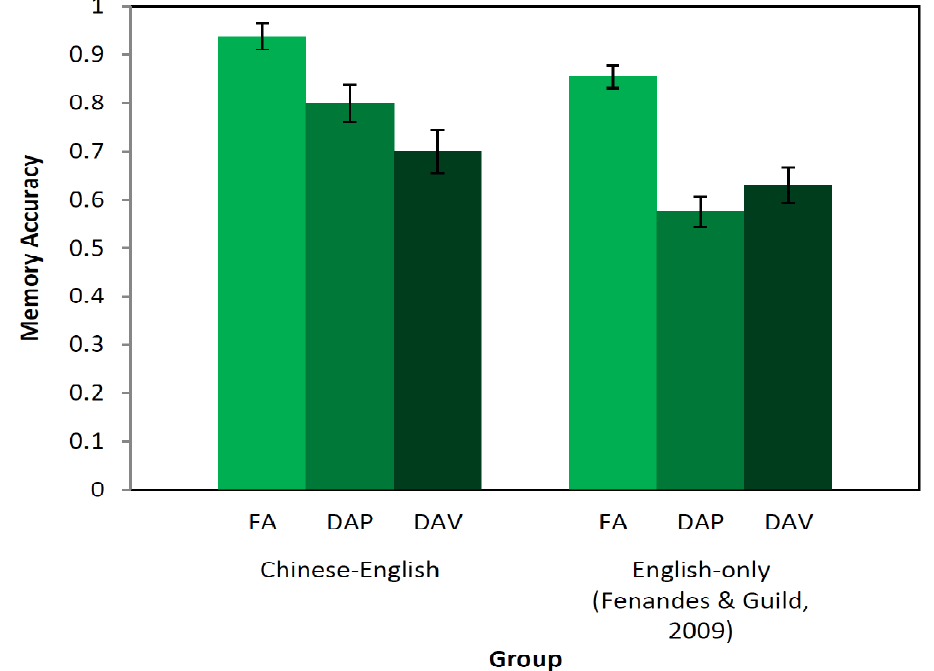
Figure 1. Memory accuracy for Chinese characters in Chinese-English Participants, and for English words in English-only participants from Fernandes and Guild (2009) [23], under FA = full attention, DAP = divided attention phonological, DAV = divided attention visuo-spatial retrieval